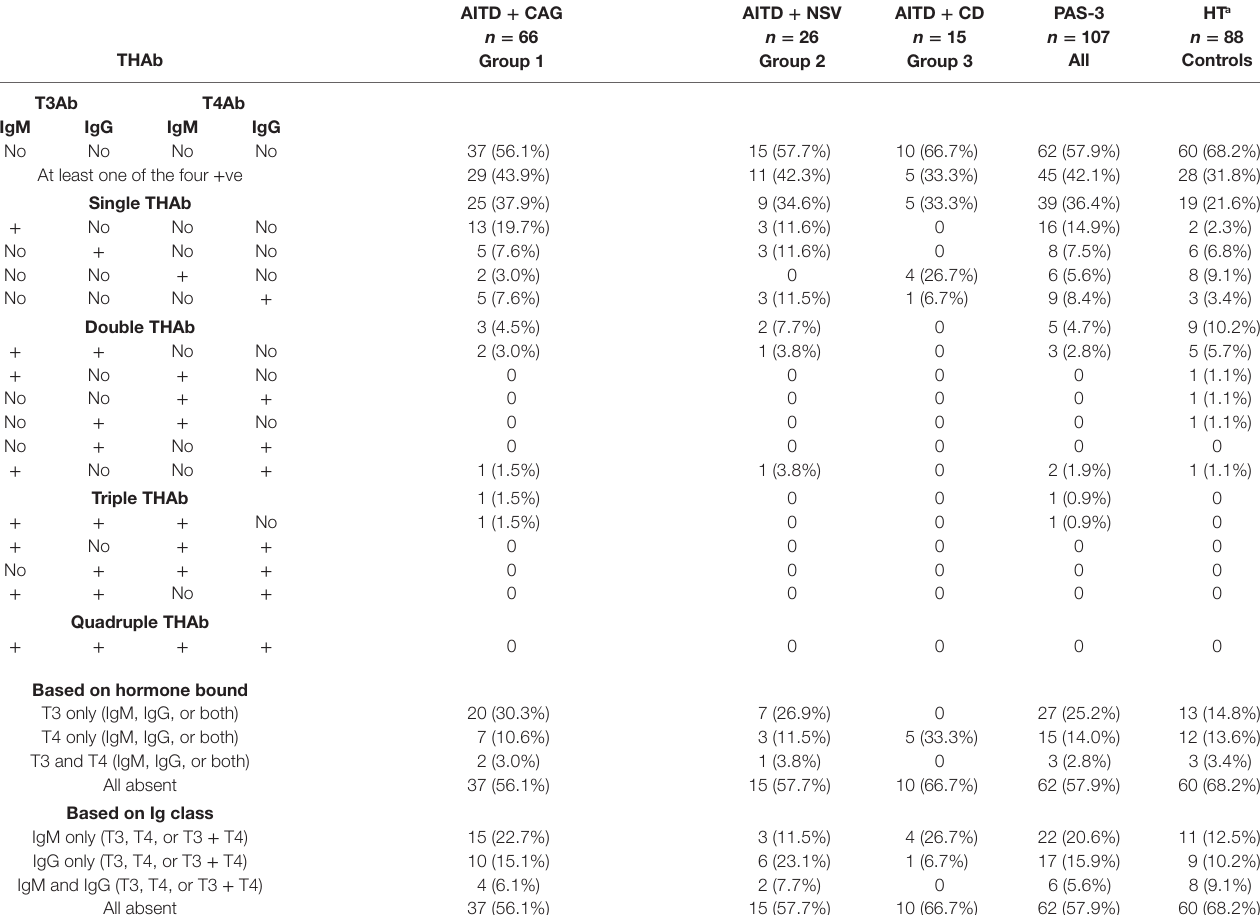
TaBle 2 | Prevalence and repertoire of